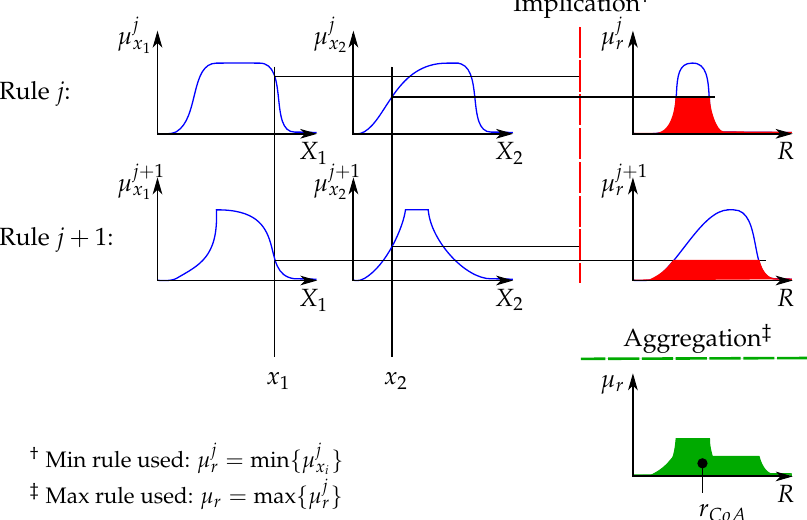
Figure 9. A general Mamdani fuzzy inference